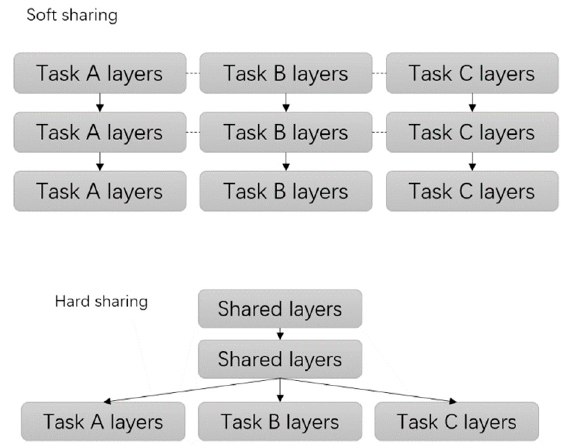
Figure 1. Two different parameter-sharing methods in multi-task learning.